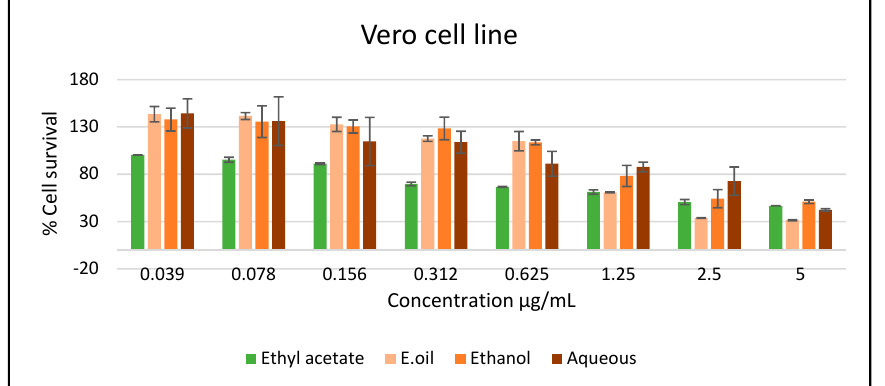
Figure 4. The cytotoxic activity of the A. citrodora extracts and essential oil against the Vero cell line. Results represented as mean ± SEM.